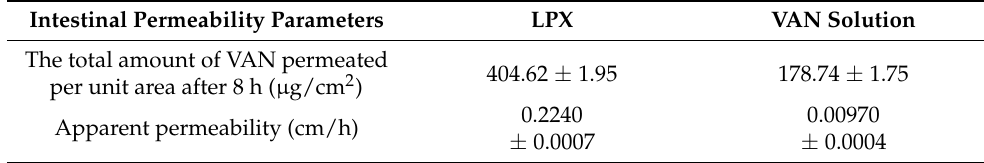
Table 4. Intestinal permeability parameters of VAN after application of VAN solution and LPX.